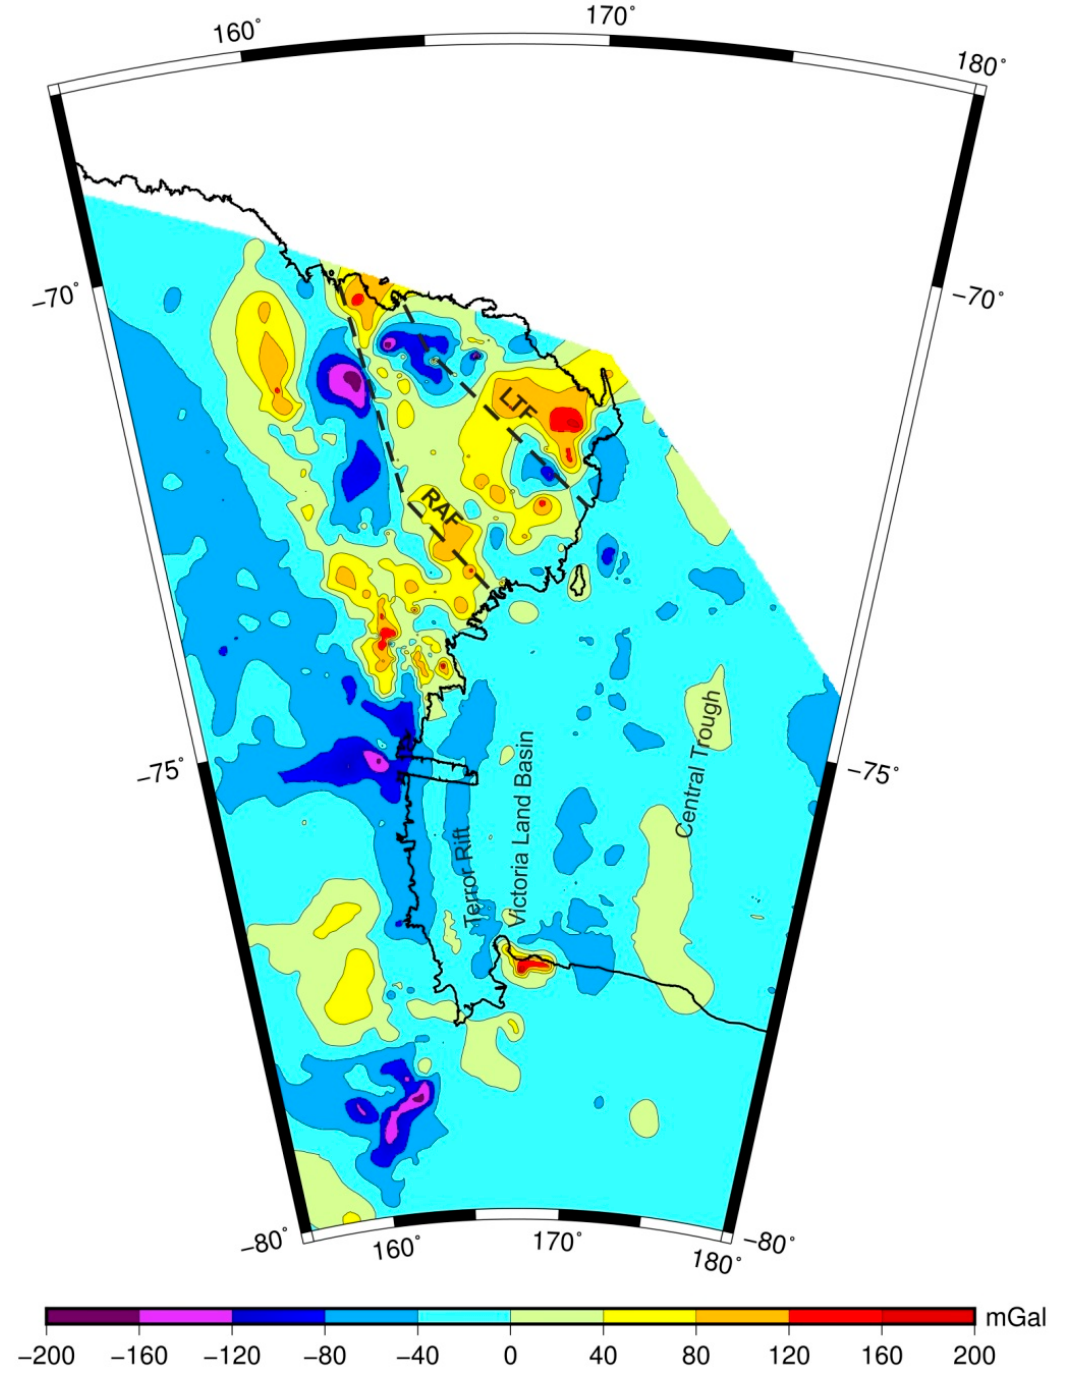
Figure 12. Gridded data of Free-Air Gravity (FAG) anomalies (mGal) in Victoria Land (contour interval at 40 mGal).